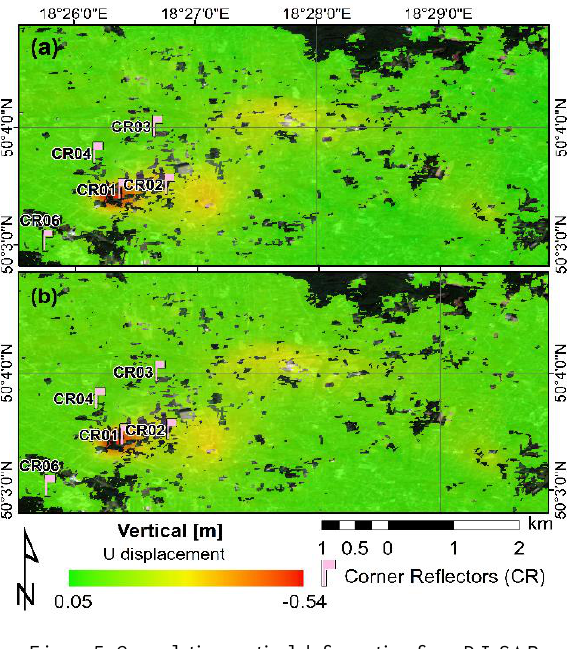
Figure 5. Cumulative vertical deformation from DInSAR estimated for Sentinel-1 data only (a) and for Sentinel-1 and